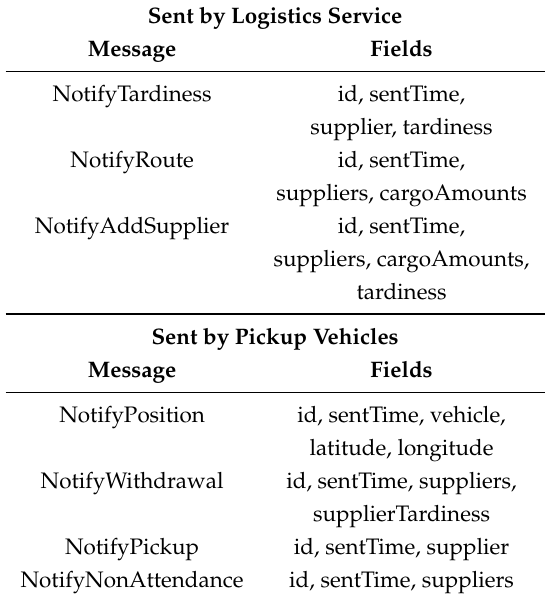
Table 2. DMRVR messages.